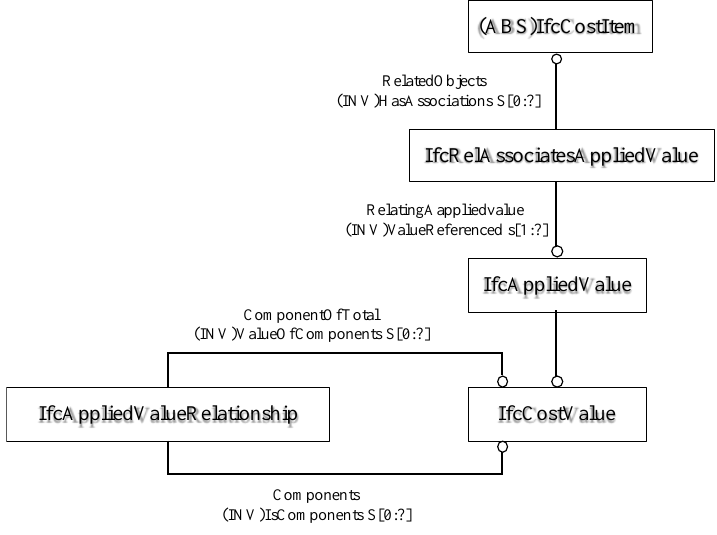
Figure 4. Cost information’s extension model.